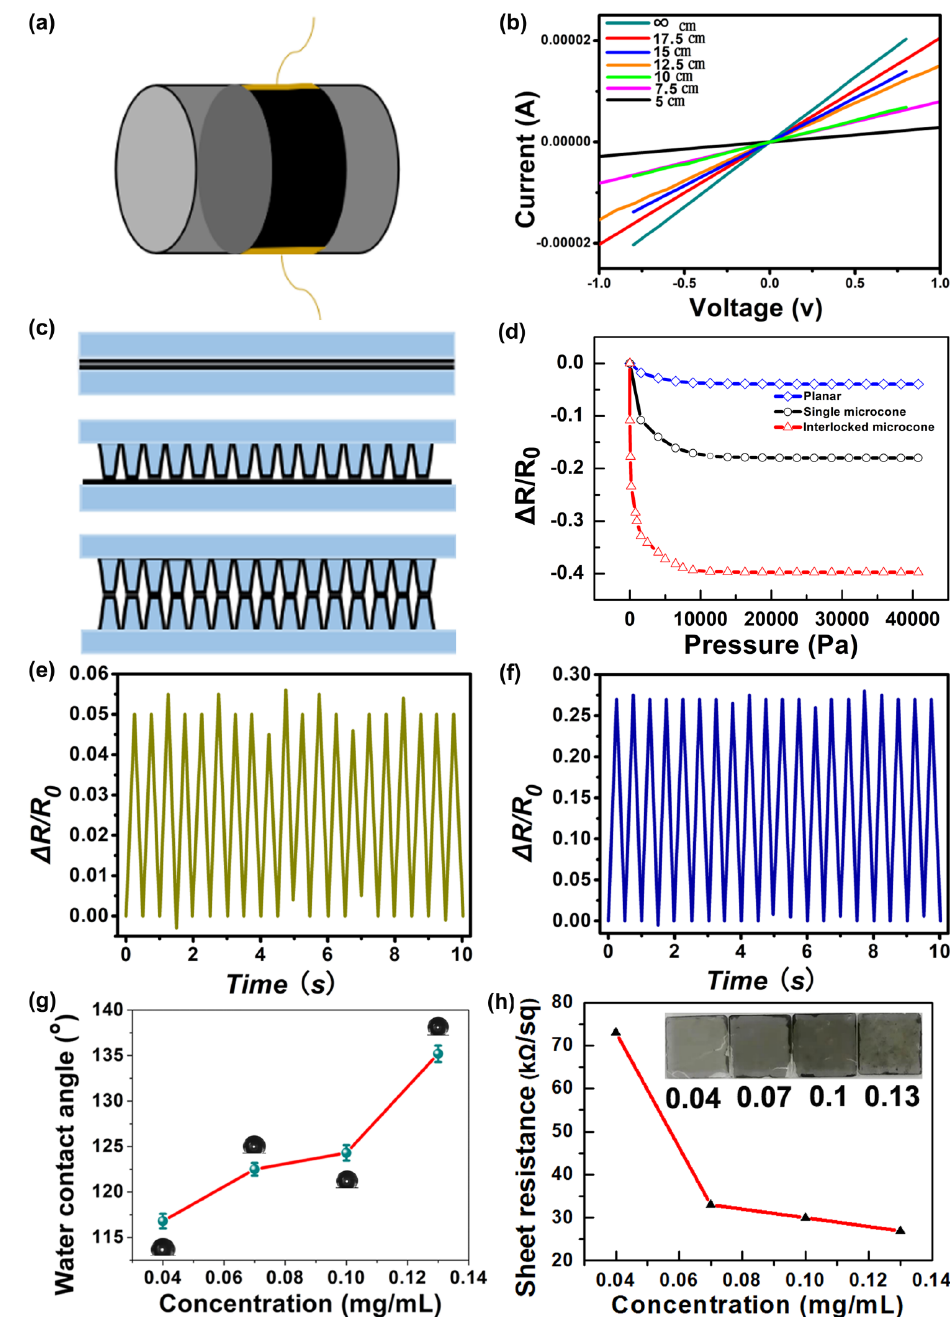
Figure 4. The performance test of pressure sensors: ( a ) schematic diagram of pressure sensor settled on the curved surface; ( b ) the current–voltage (I-V) curves of pressure sensor under different bending radius; ( c ) the diagram of three distinct sensor; ( d ) pressure sensitivities of three sensor topologies: planar film (blue), single microcone (black), and interlinked microcone (red), respectively; ( e , f ) the real-time resistance change of the sensors without microstructure and with microcone structure during cyclic bending; ( g ) the content angle of CNTs networks under different concentration; ( h ) the resistance of CNTs networks under different